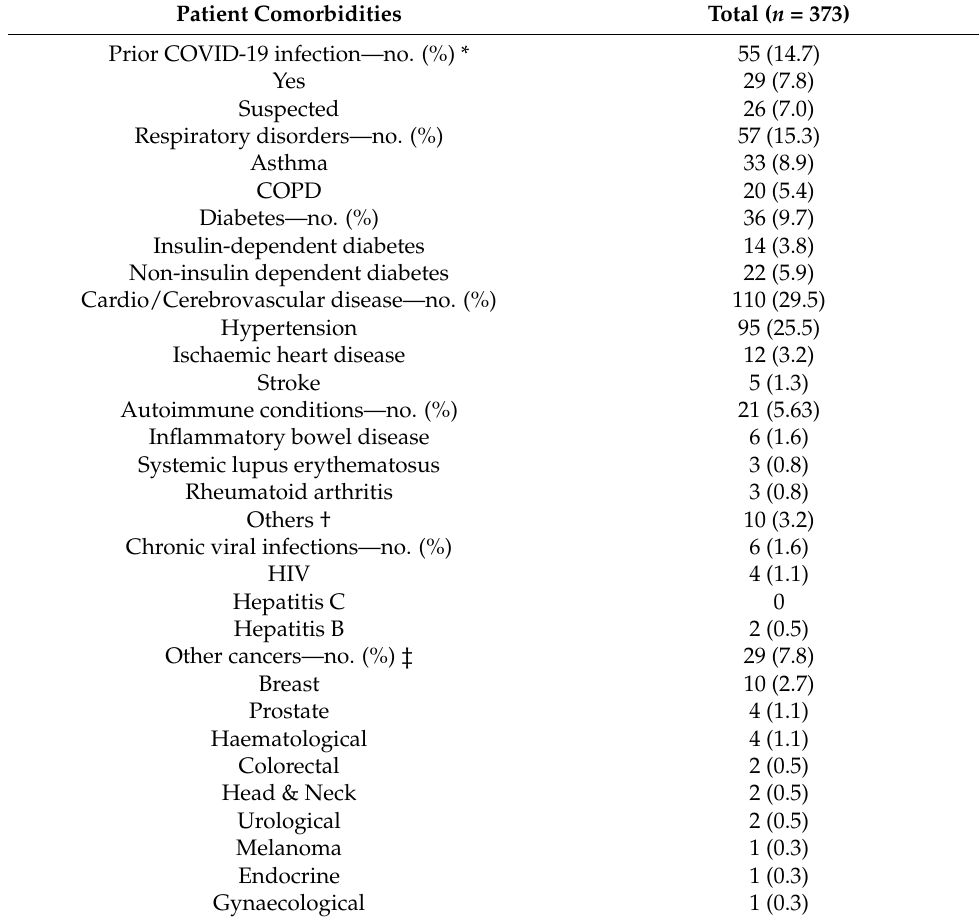
Table 2. Patient